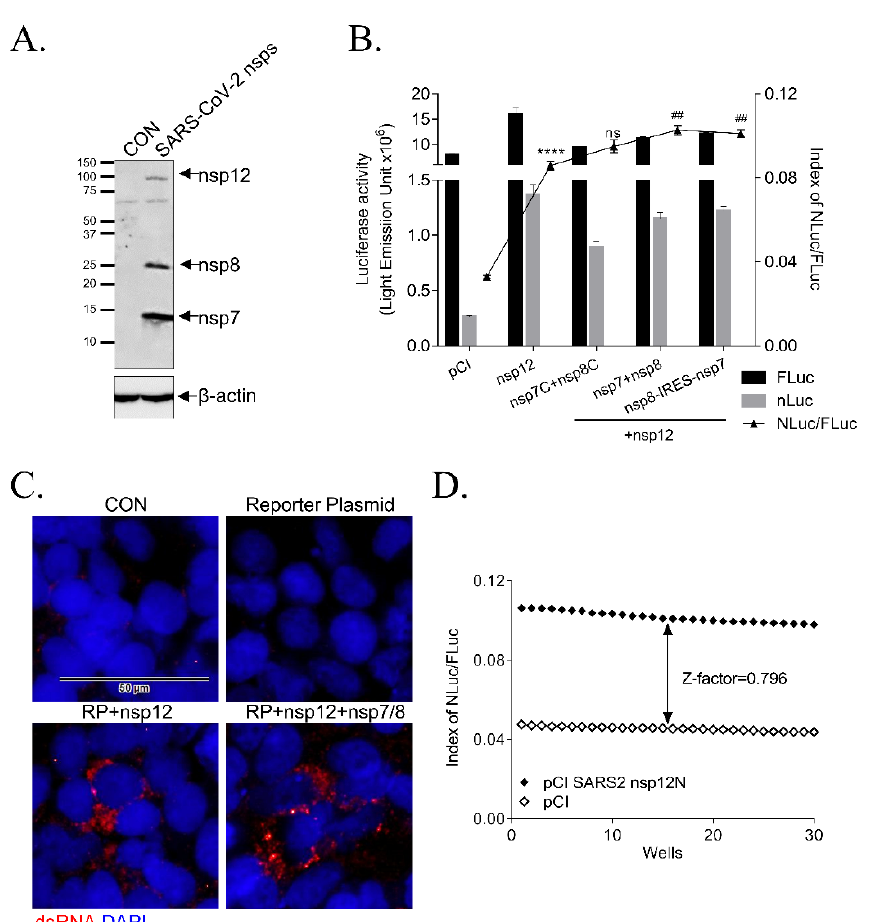
Figure 3. Effect of SARS-CoV-2 nsp7 and nsp8 on RdRp activity. ( A ) The expression of nsp7, nsp8 and nsp12 genes was detected with an anti-Flag antibody using Western blotting 24 h after trans- fecting HEK293 T cells with pCI (CON), pCI-SARS2-nsp12N, pCI-SARS2-nsp7C, or pCI-SARS2-